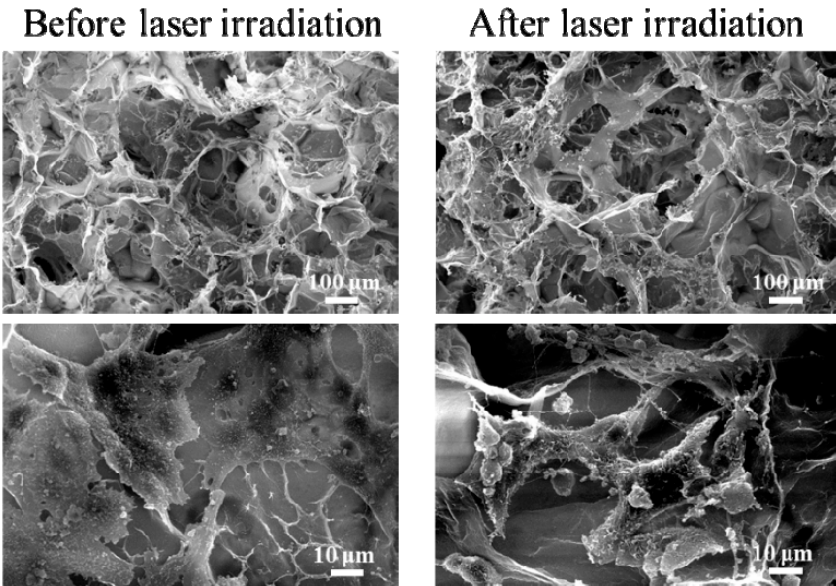
Figure 4. Distribution and morphology of breast tumor cells in the AuNRs–gelatin composite scaffold before and after laser irradiation (805 nm, 1.6 W cm − 2 ) for 3 min.